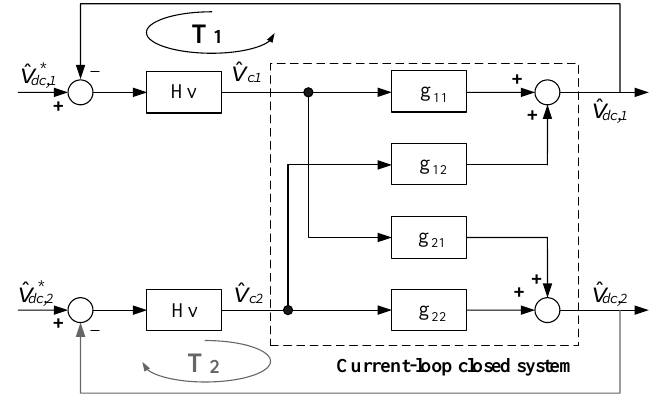
Figure 4. Voltage control loop block diagram of current-loop closed plant system.